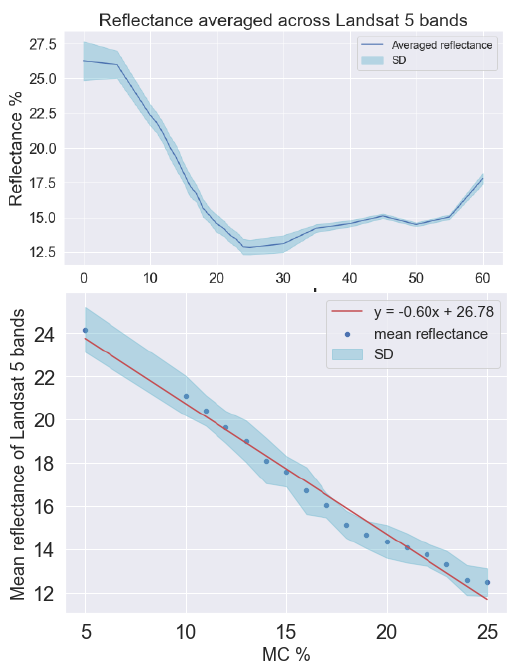
Figure 2(a & b). A monotonic relationship between soil MC and reflectance averaged across all the vis-NIR Landsat 5 wavelengths is apparent below 25% MC. Between 5–25% MC, the relationship is linear. (Note SD is the standard